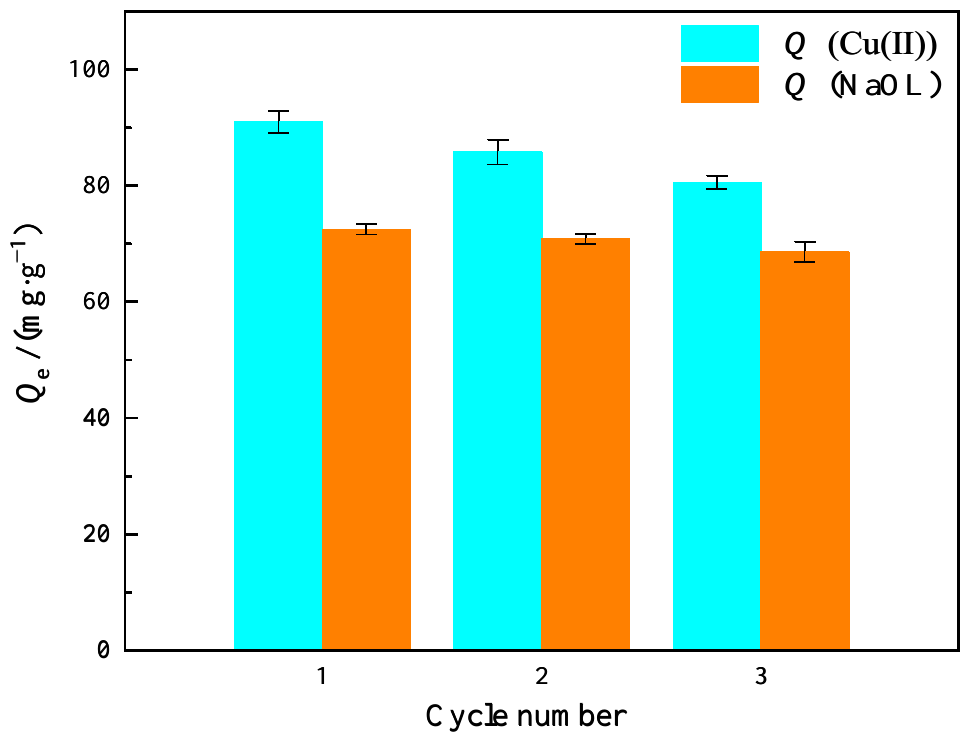
compared to other materials is given in Table 5 [18–21,23–25,29,49–54].